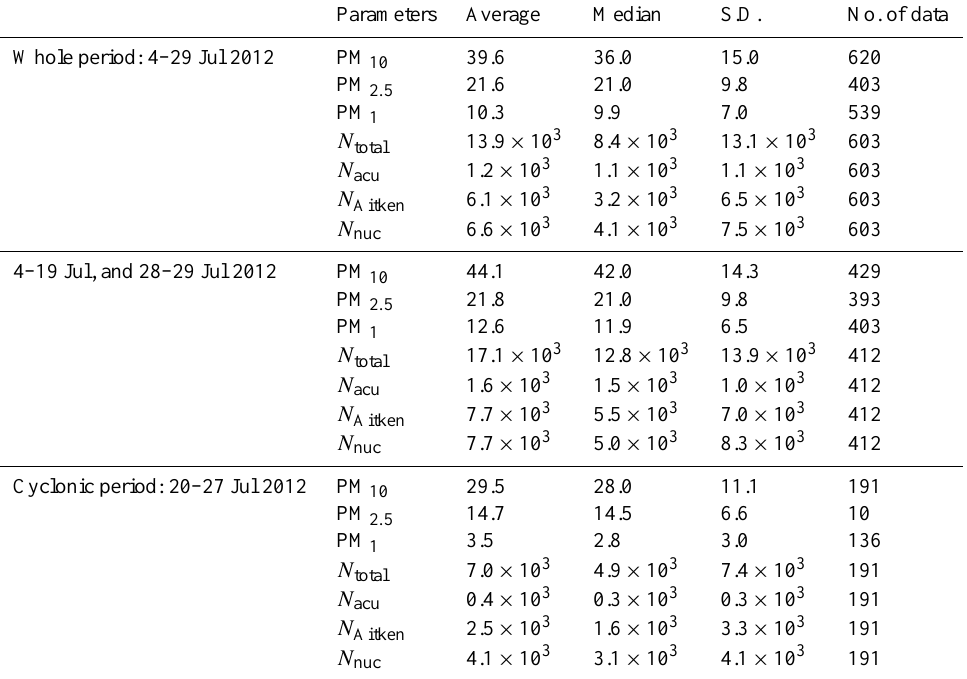
Table 1. Statistic of particle mass and number concentrations measured. Units: PM 10 , PM 2 . 5 and PM 1 inµgm − 3 ; and for N total , N acu , N Aitken and N nuc incm − 3 . Note: PM 2 . 5 measurement interrupted during the typhoon